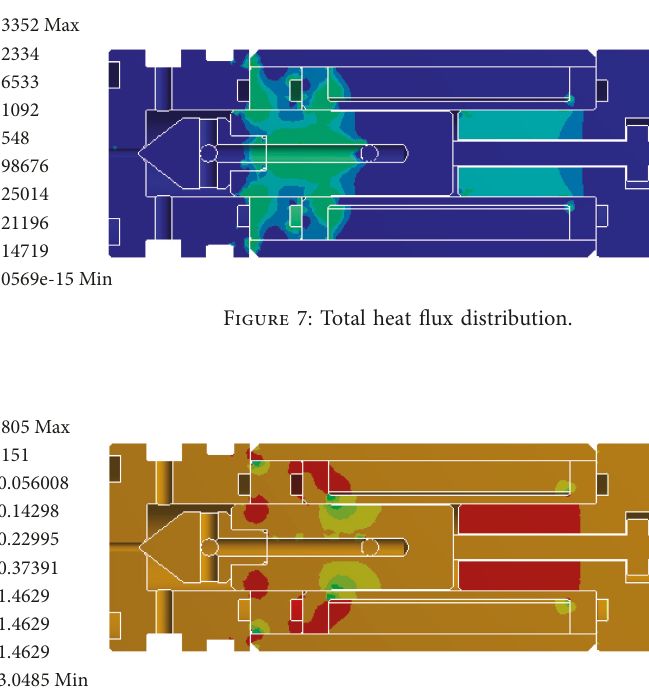
Figure 8: X -Direction heat flow distribution.